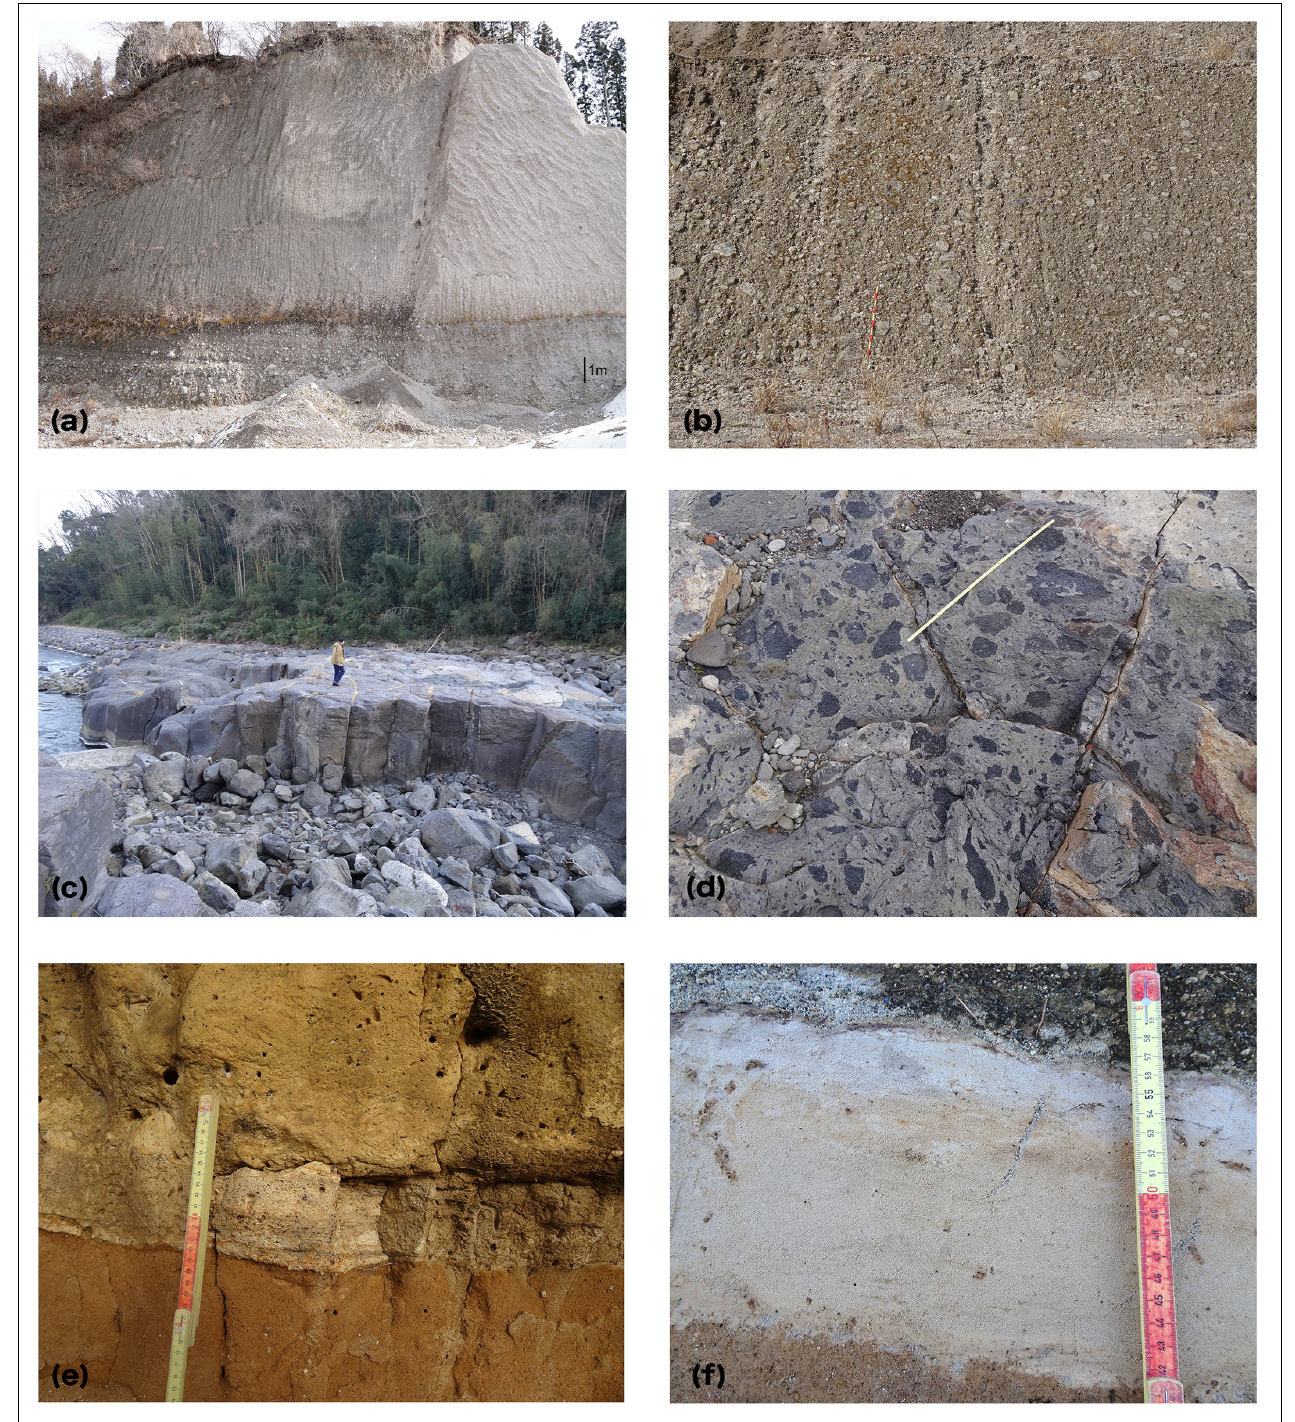
FIGURE 3 | Typical outcrops of Aso-4 PDC and tephra fall deposits. (a) Non-welded facies (11 km SE from the source). The lower part is the breccia facies. (b) Enlargement of the non-welded facies (30 km N). The scale is 1 m long. (c) Welded facies (33 km ENE). (d) Enlargement of the welded facies. Note plan view of fiammes [location is the same as (c) ]. (e) Distal facies of the 10–15 cm-thick Aso-4 PDC deposit (white and pale orange-colored part, 117 km NNW). (f) A 12 cm-thick Aso-4 tephra fall deposit at Shari Town, Hokkaido (1,695 km NE from the source).